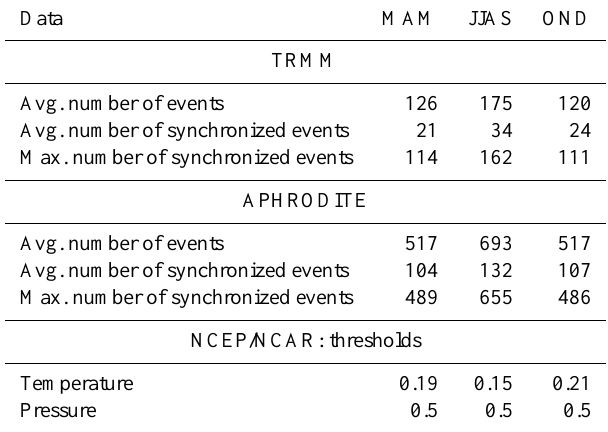
Table 3. Details of network construction and thresholding. Extreme rainfall event networks: the average number of events per grid point during the considered period (MAM, JJAS, or OND), the mean number of synchronized events, and the maximal number of syn- chronized events. Temperature and pressure networks: thresholds of the Pearson correlation for the MAM, JJAS, and OND